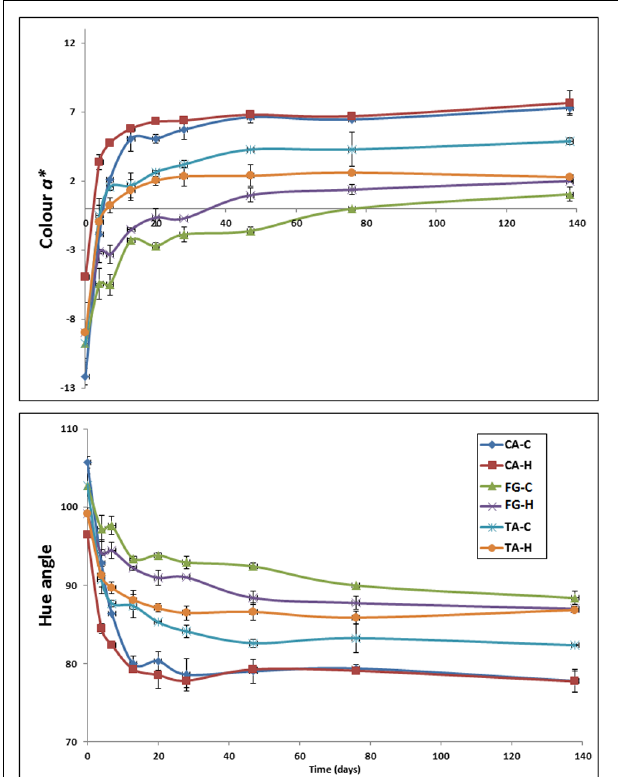
FIGURE 2 | Evolution of color parameters a ∗ (upper) and h ab (lower) during fermentation in the diverse treatments. Error bars denote standard deviation calculated from duplicate fermentation vessels. CA-C, cured control; CA-H, heat-shocked cured olives; FG-C, refrigerated fresh green control; FG-H, heat-shocked refrigerated fresh green olives; TA-C, control of traditional olives; and TA-H, heat-shocked traditional olives. All treatments were applied to the Aloreña de Malaga